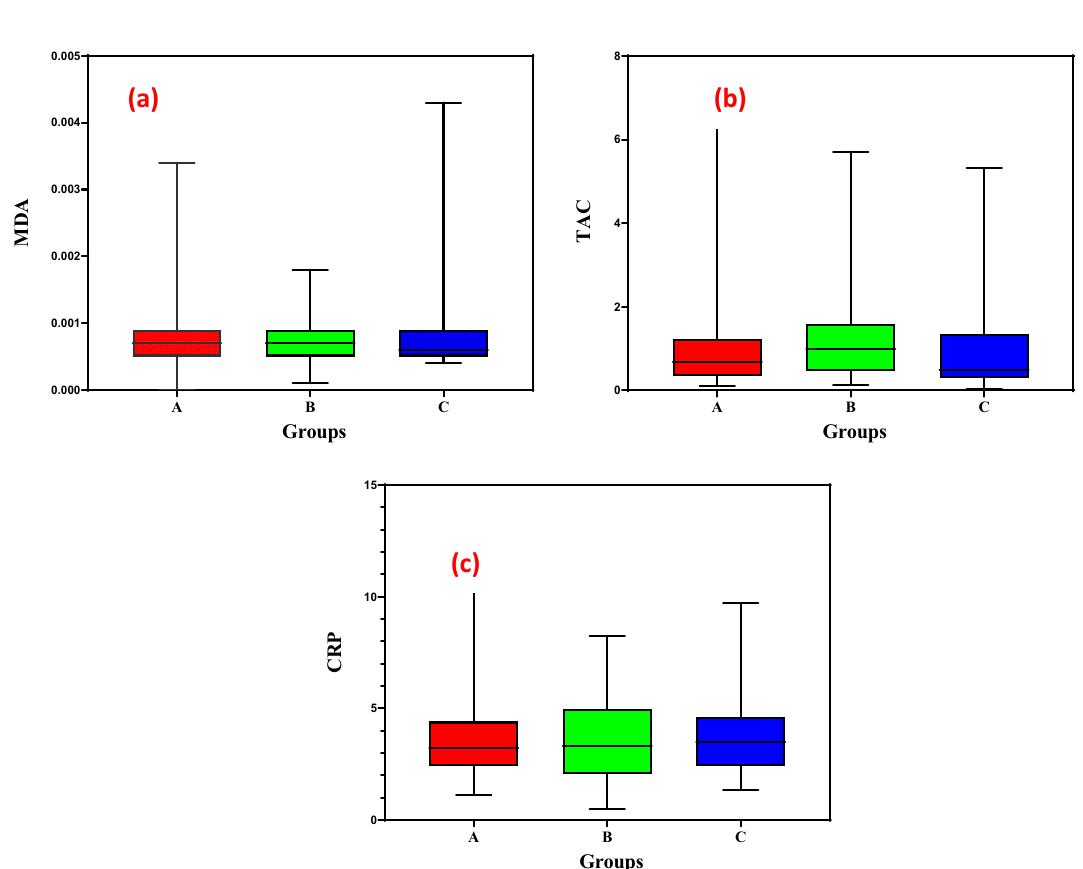
Figure 2. A measure of the average concentrations of ( a ) MDA (µm/mM cr) and ( b ) TAC (mM/mM cr) in urine samples, and ( c ) CRP (mg/L) in blood samples (A: kitchen workers, B: individuals living near restaurants, and C: control